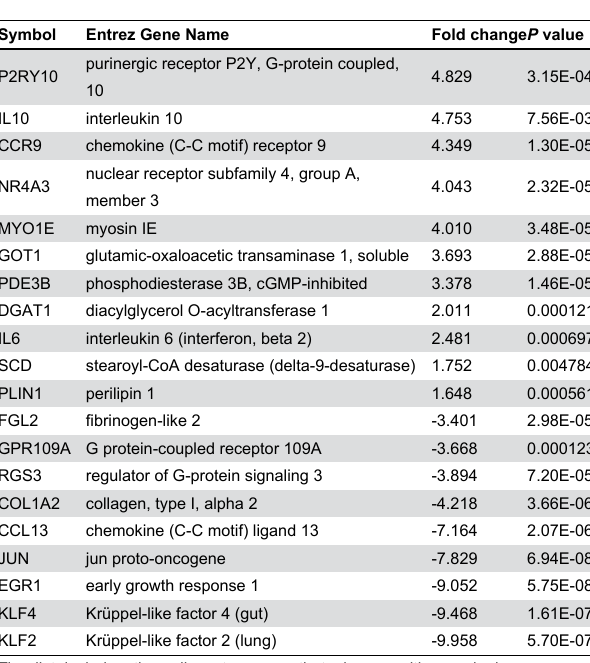
Table 10. Bone marrow adipocyte genes most highly up- and down-regulated with age during a high fat